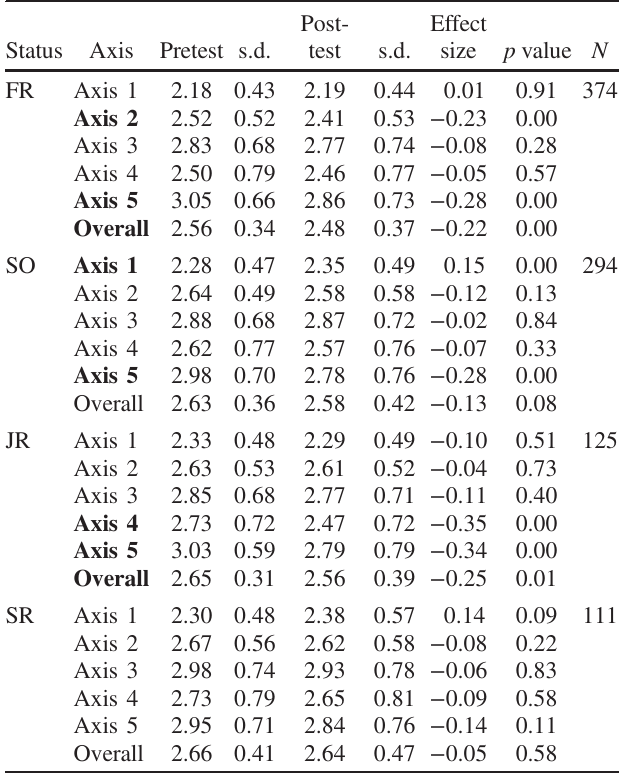
TABLE X. EBAPS baseline pretest and post-test results